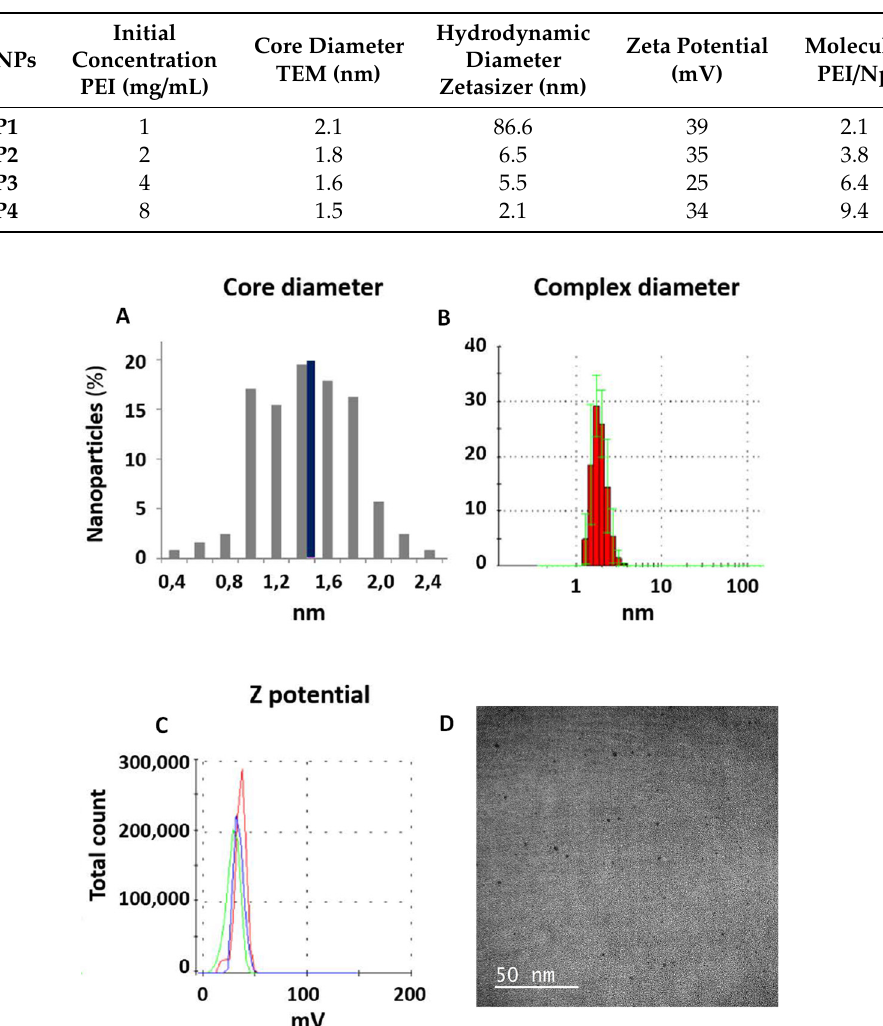
Table 1. Summary characterization of the gold ‐ polyethylenimine (Au ‐ PEI) nanoparticles (NPs) synthesized.